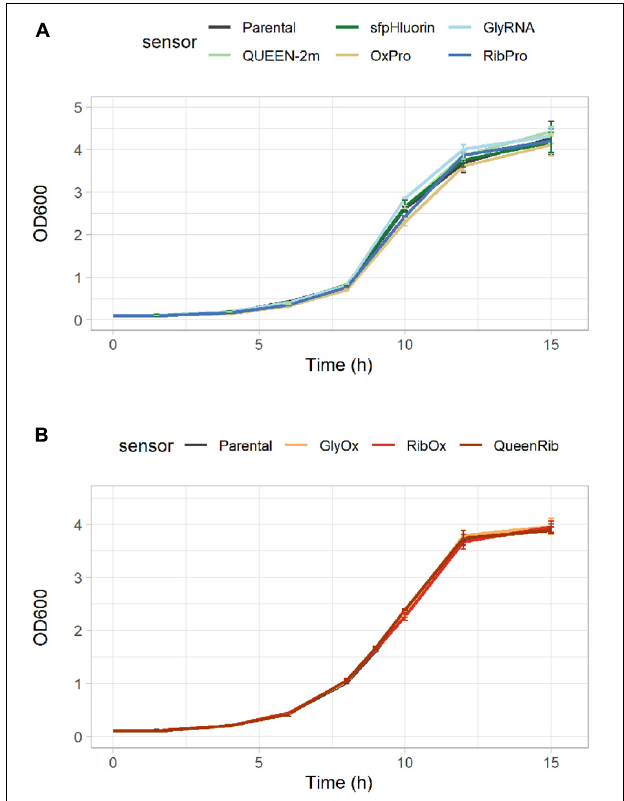
FIGURE 3 | Growth comparison of CEN.PK113-7D strains bearing biosensors. Growth curves showing the increase in optical density at 600 nm (OD600) over time for the parental CEN.PK113-7D strain and its derivatives bearing either (A) one or (B) a pair of